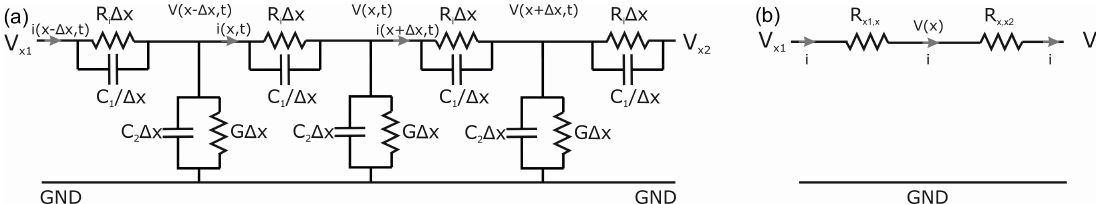
Figure 2. Equivalent electrical circuit for ( a ) liquid crystal (LC) lenses with modal and hole patterned configuration [55,56] and ( b ) the transmission electrode